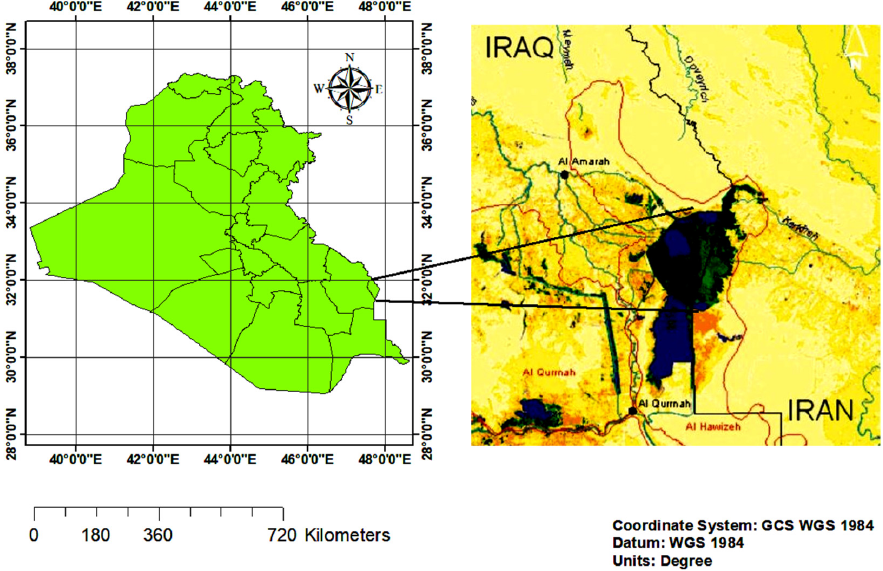
Figure 1. Geographical location of the study area.